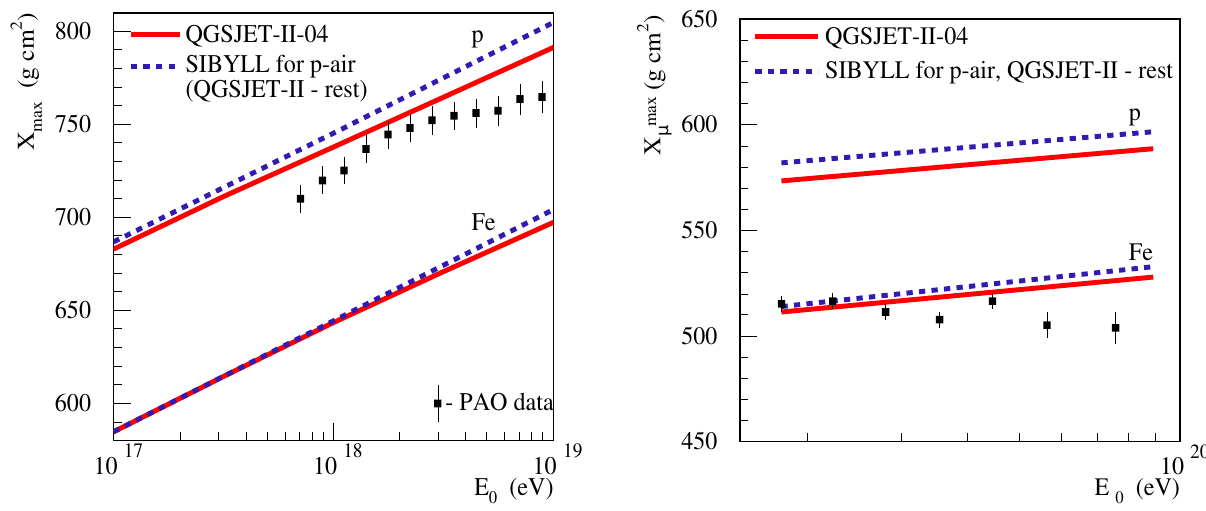
Figure 5. Primary energy dependence of X max (left) and X µ max (right) for proton- and iron-induced vertical EAS, as calculated using the QGSJET-II-04 model (solid lines) or applying SIBYLL-2.3 for the treatment of proton-air collisions and QGSJET-II-04 for the rest of the hadron cascade (dashed lines). PAO data [23, 31] are shown by